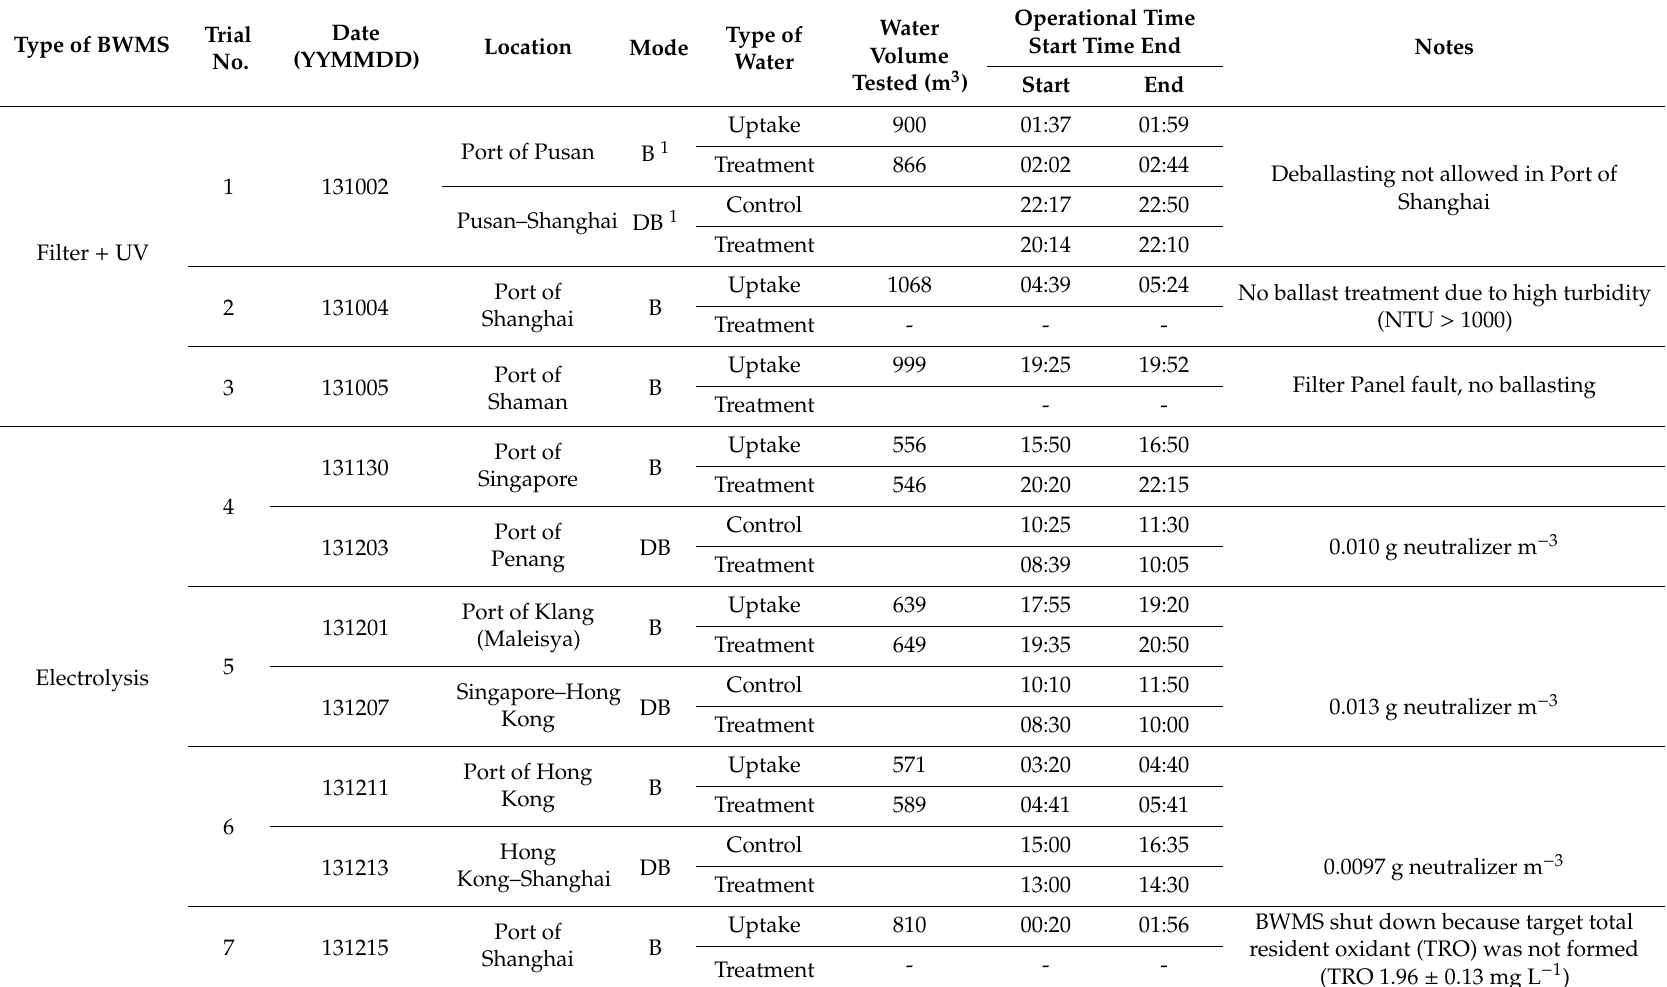
Table 2. Summary of ballasting and deballasting operations for three types of BWMS installed on vessels. Type of